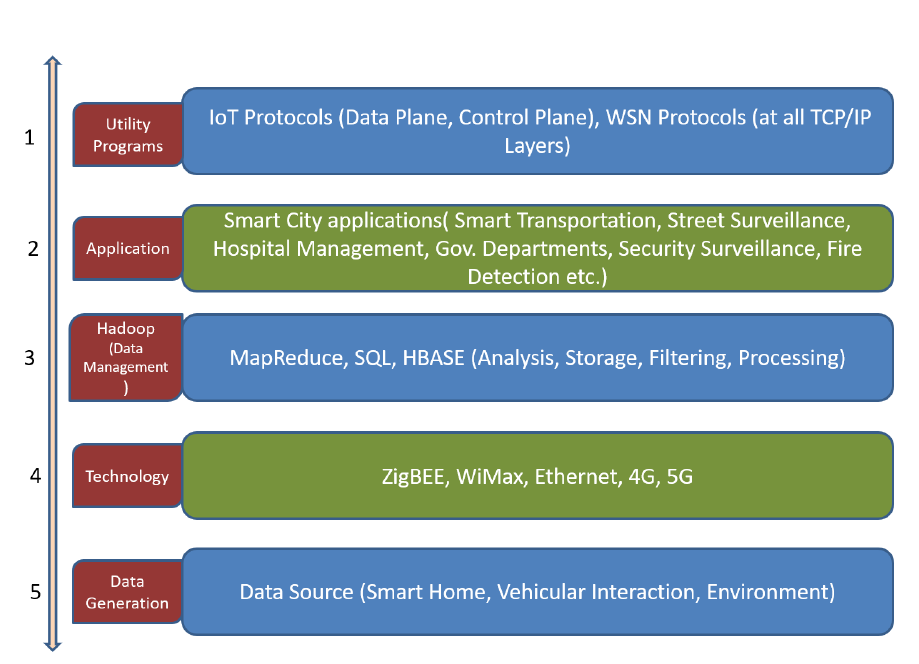
Figure 1. Structure of Smart City Big Data